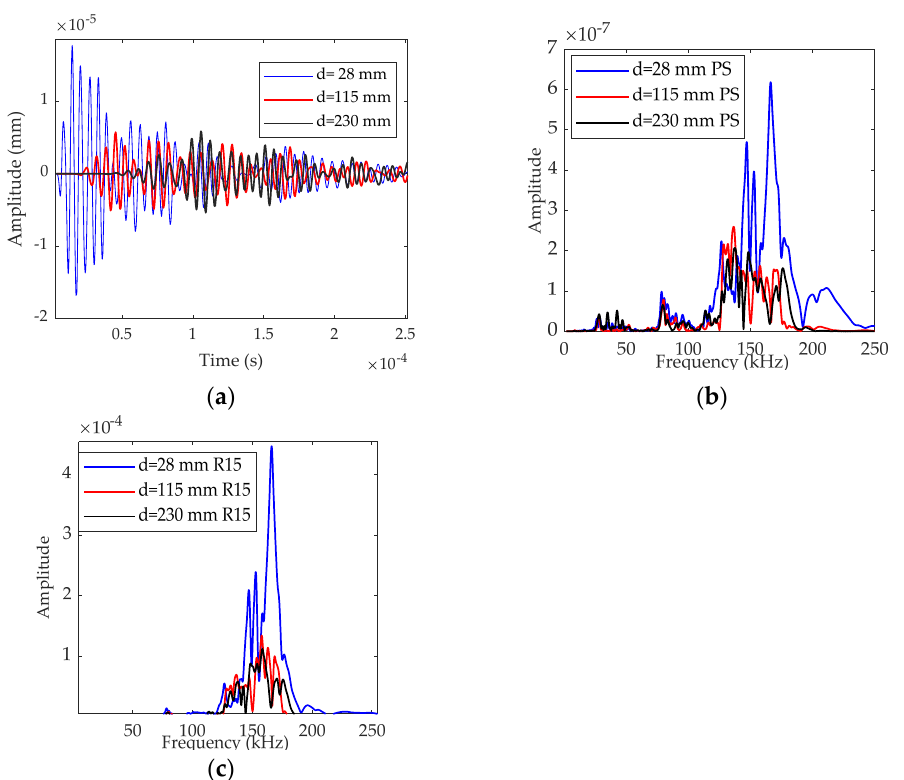
Figure 6. Simulated signal without AE sensor effect in ( a ) time domain and ( b ) frequency domain. ( c ) Fast Fourier transform (FFT) of the simulated signals recorded by the R15 sensor.